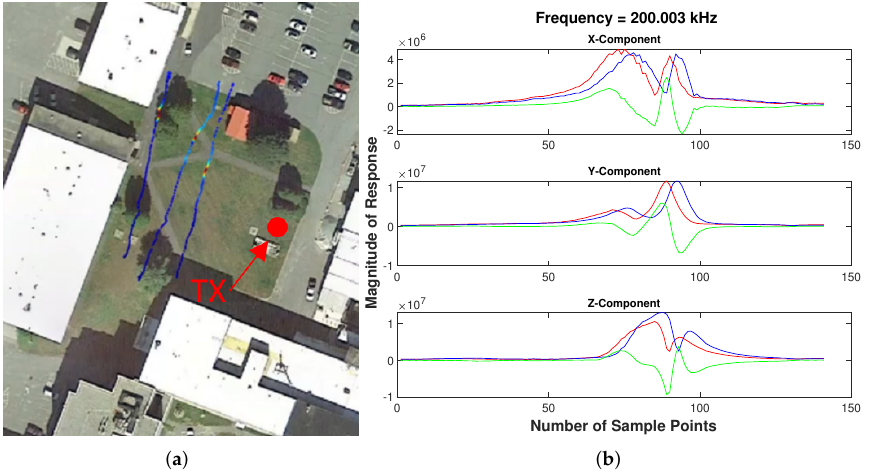
Figure 13. Live time detection map and component plotting with target for a mixed grass and concrete environment. ( a ) Detection map—heat map where red correlates to a large increase in signal. ( b ) Survey—red and blue lines plot the response from the front and back gradiometer receivers, respectively. The green line plots the magnitude of the front RX subtracted by the magnitude of the back RX.